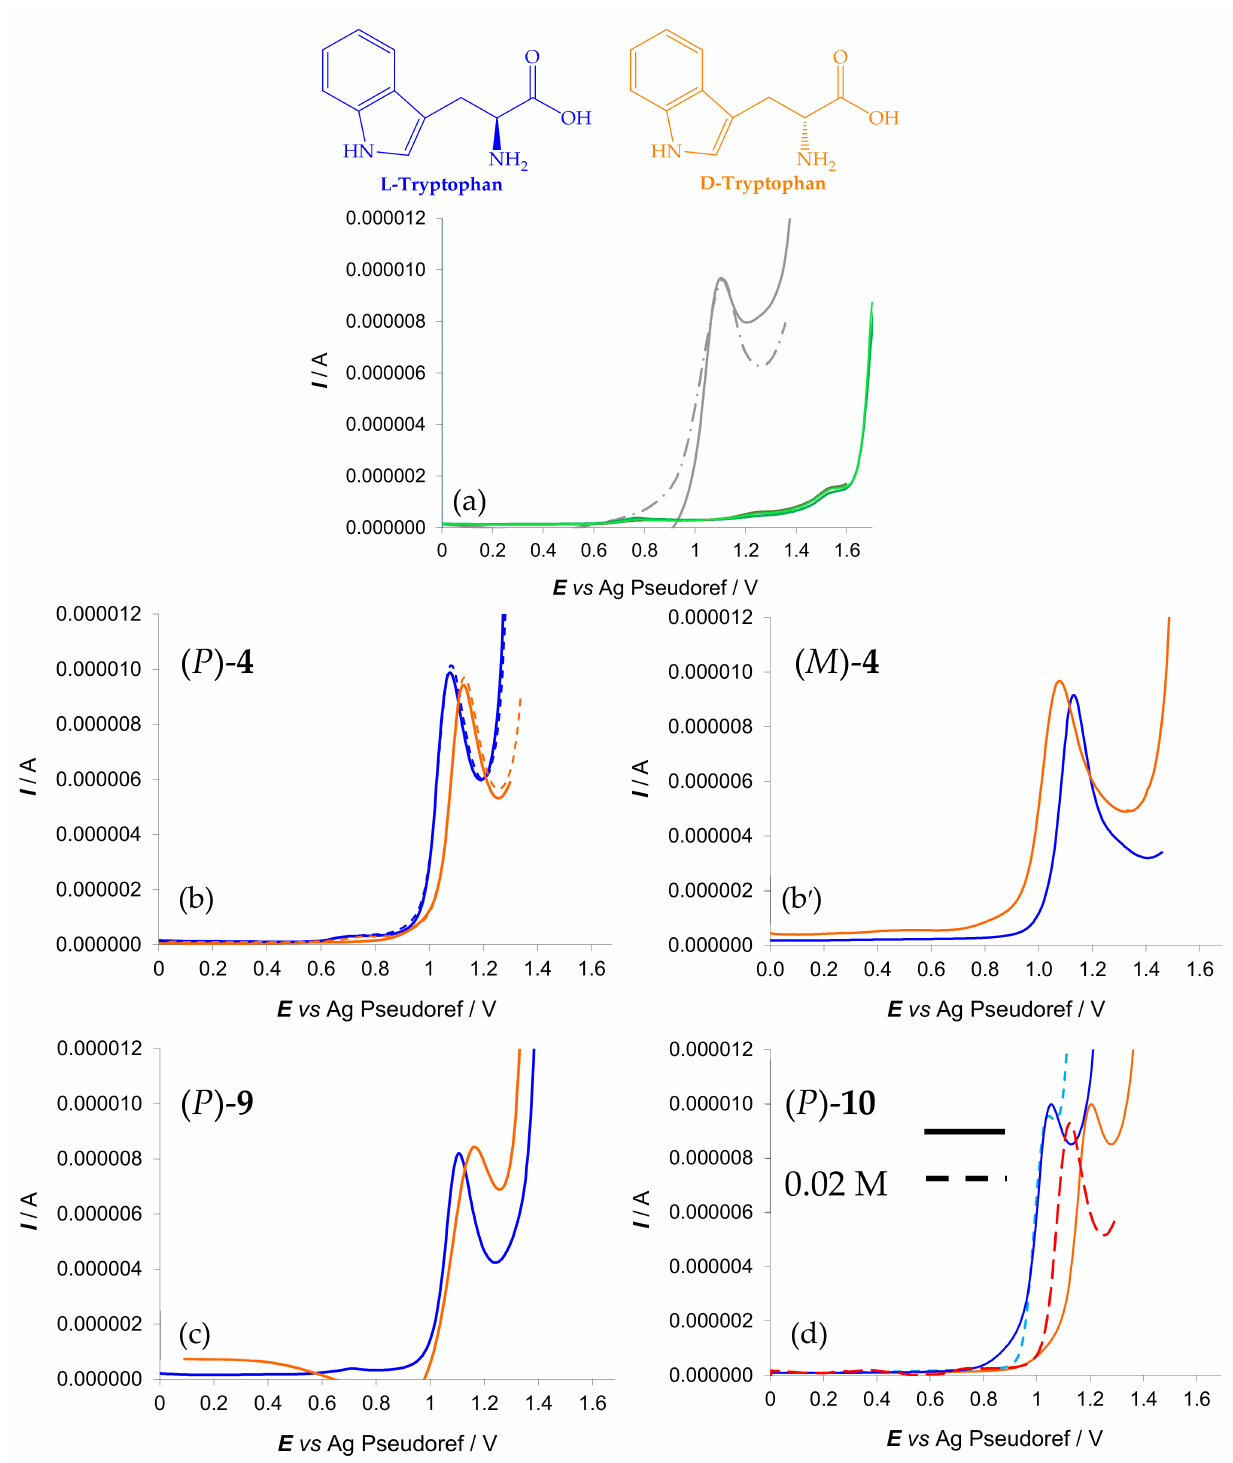
Figure 11. ( a ): DPV features of L - and D - Trp (grey dashed and straight lines respectively) in the absence of inherently chiral selectors and of ( P )- 4 . ( P )- 9 and ( P )- 10 selectors in (BMIM)NTf 2 in the absence of the probes (green lines, as benchmarks). Enantioselection tests on L - and D -Trp (blue and orange, respectively) in (BMIM)NTf 2 with selectors ( b ) (P)- 4 0.02 M, ( b (cid:48) ) (M)- 4 0.02M, ( c ) (P)- 9 0.02 M and ( d ) (P)- 10 0.02 M (straight lines) or 0.01 M (dashed